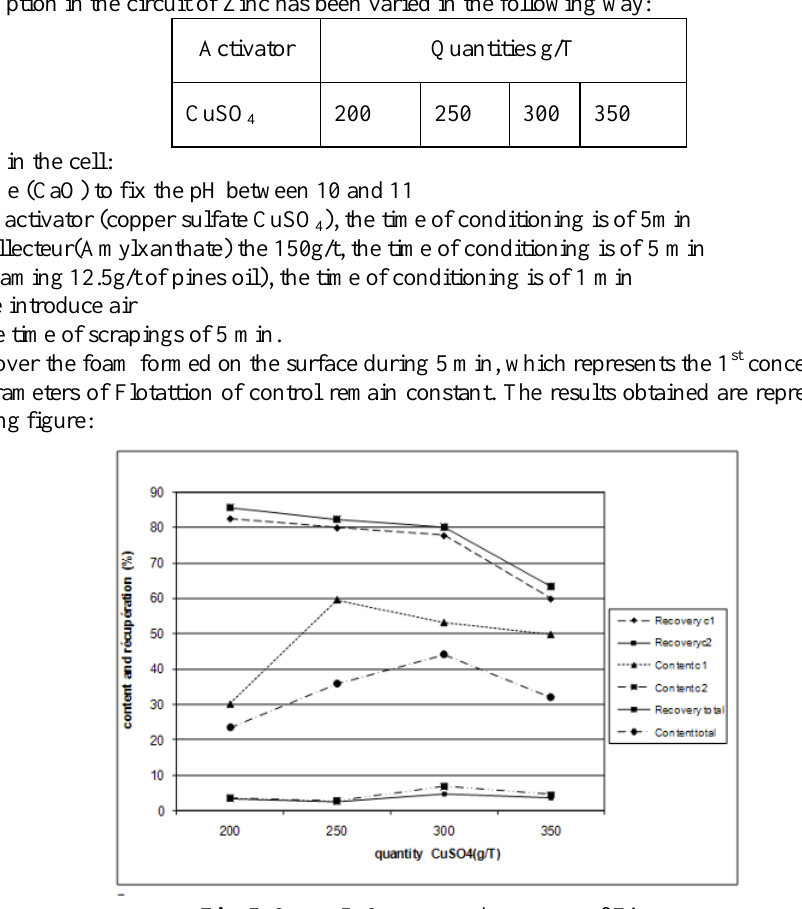
Fig. 5. Curve 5. Content and recovery of